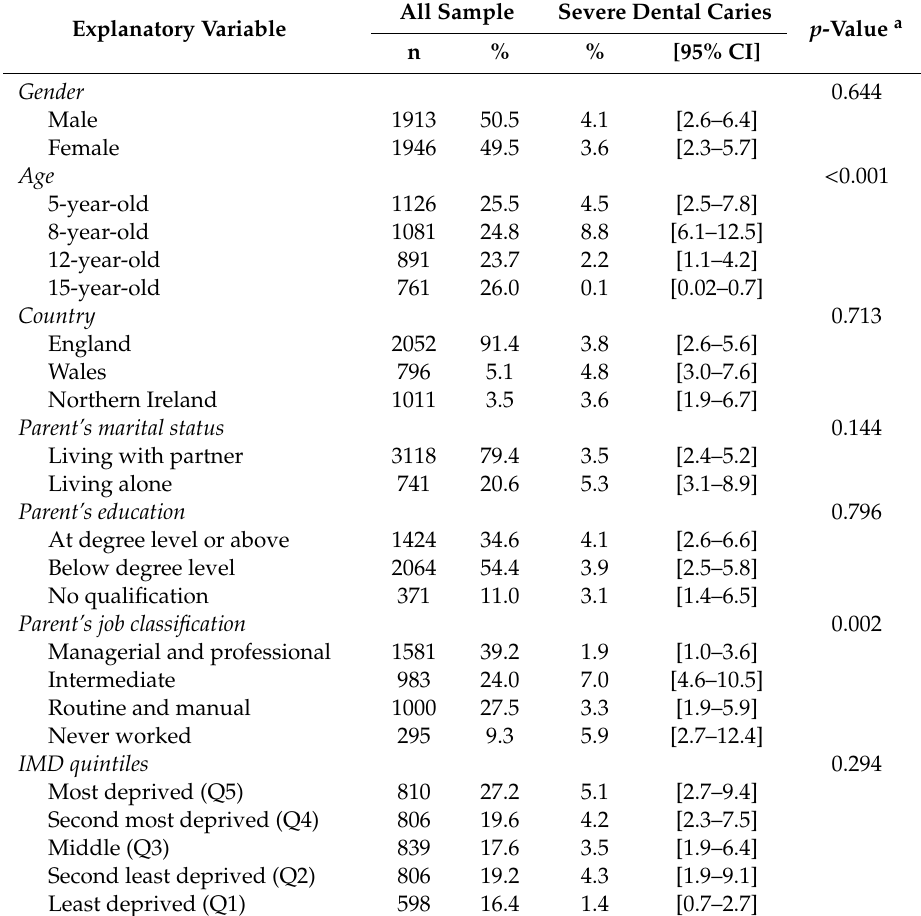
Table 1. Description of the sample and prevalence (%) of severe dental caries among children (any tooth with PUFA) by explanatory variables (n =